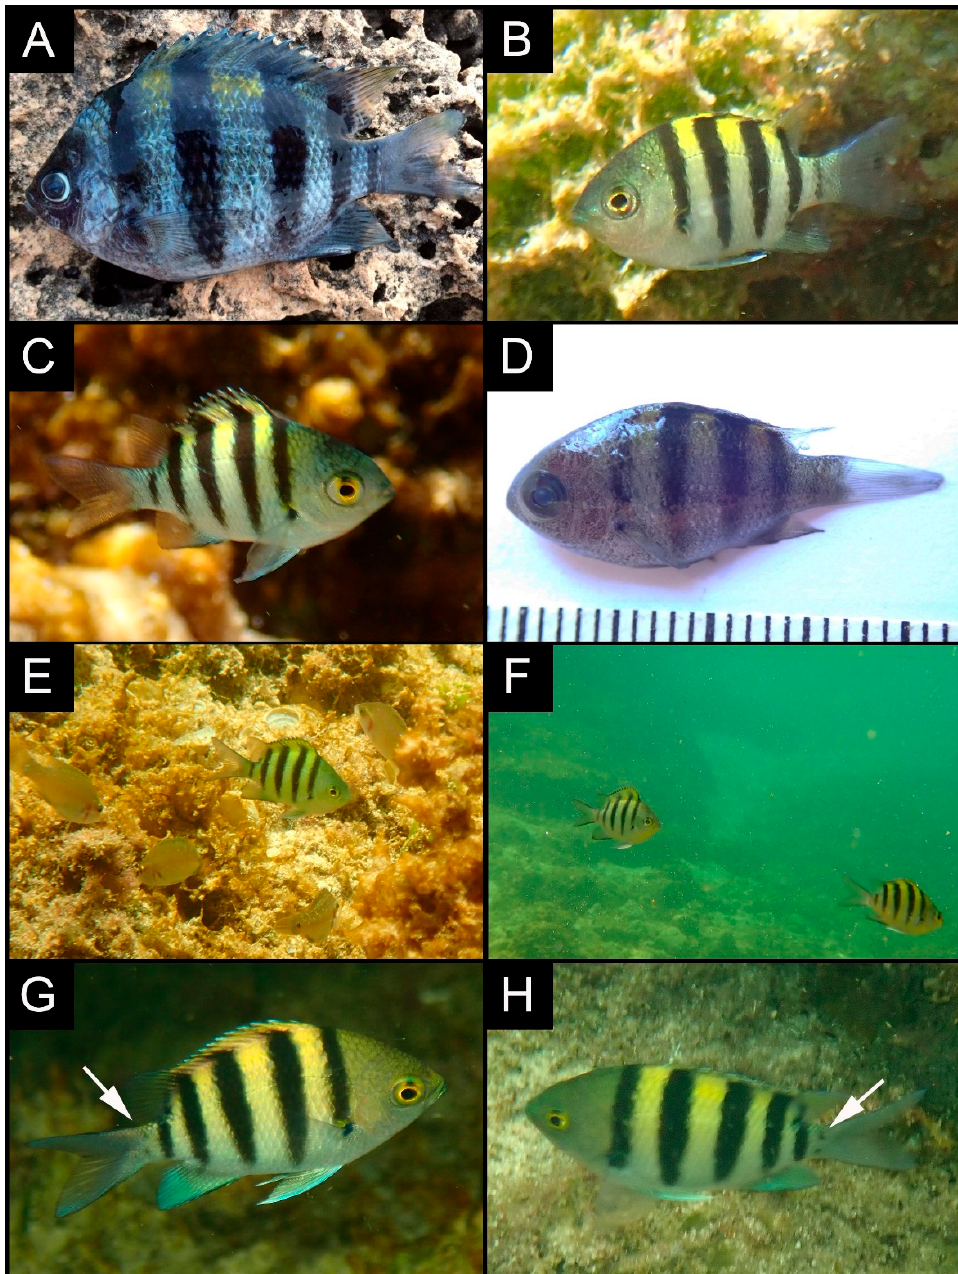
Figure 2. Specimens belonging to the genus Abudefduf Forsskål, 1775 reported in the present study from Libya. ( A–F ) Abudefduf vaigiensis . ( G,H ). Abudefduf cf. saxatilis . White arrows highlighting the from Libya. ( A–F ) Abudefduf vaigiensis . ( G , H ). Abudefduf cf. saxatilis . White arrows highlighting the two black spots on the caudal peduncle. two black spots on the caudal